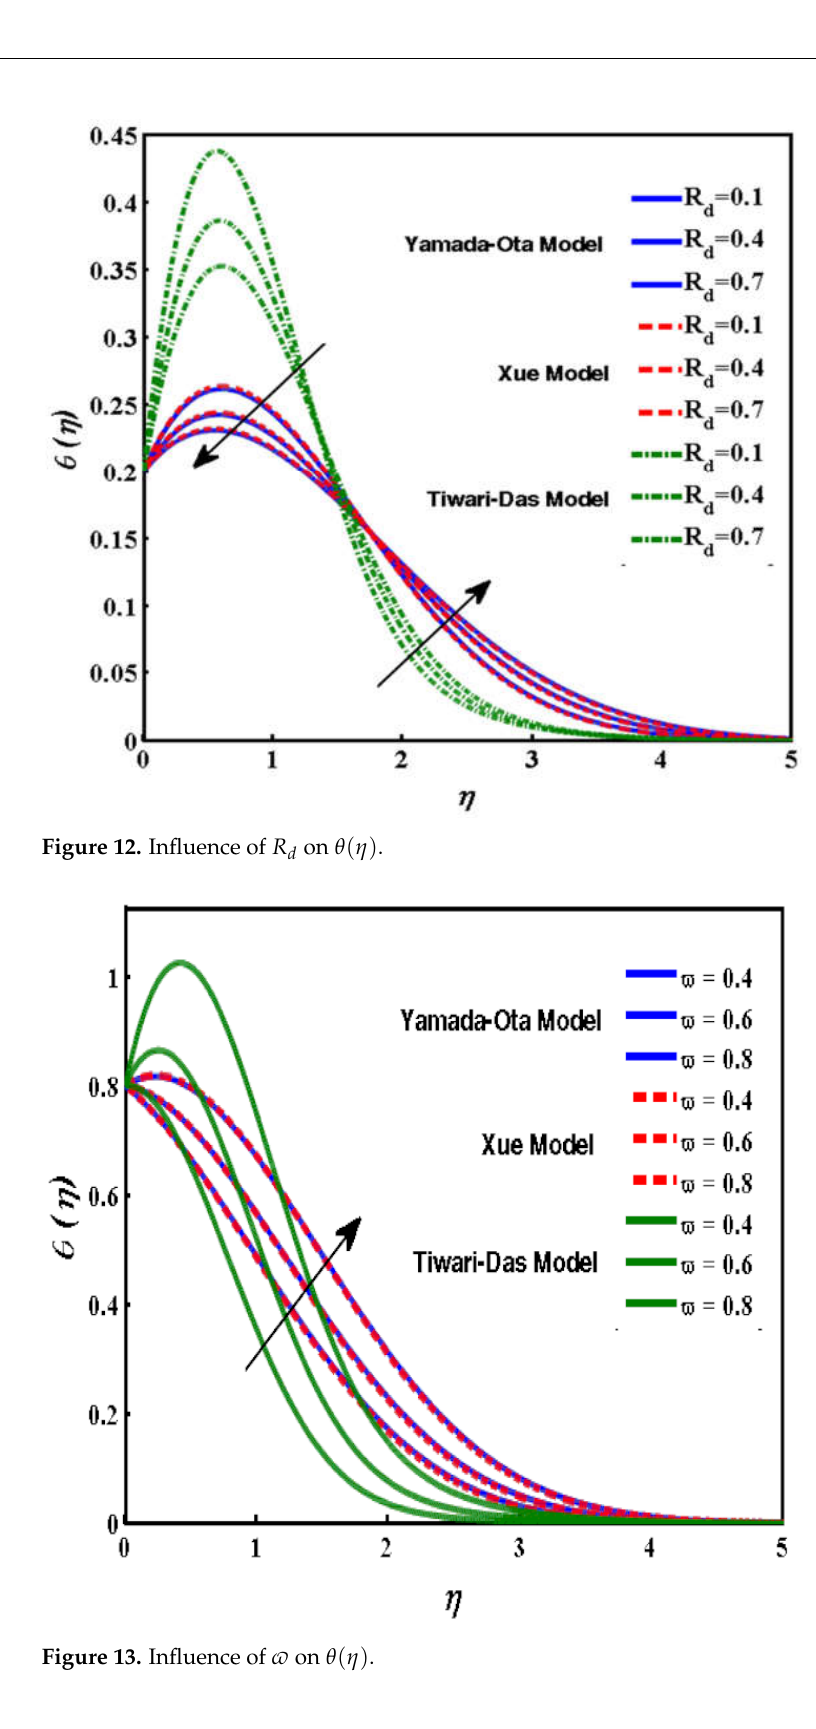
Figure 13. Influence of (cid:118) on θ ( η ) .